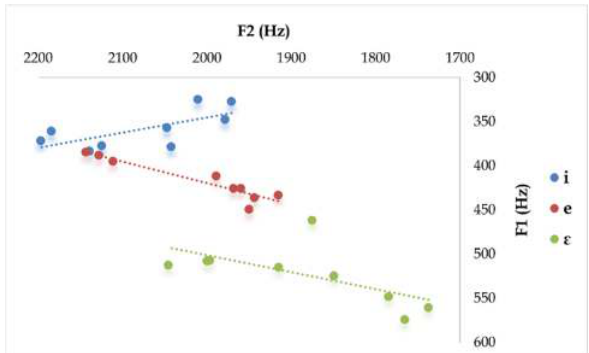
Figure 6. Scatter plot of front vowel formant